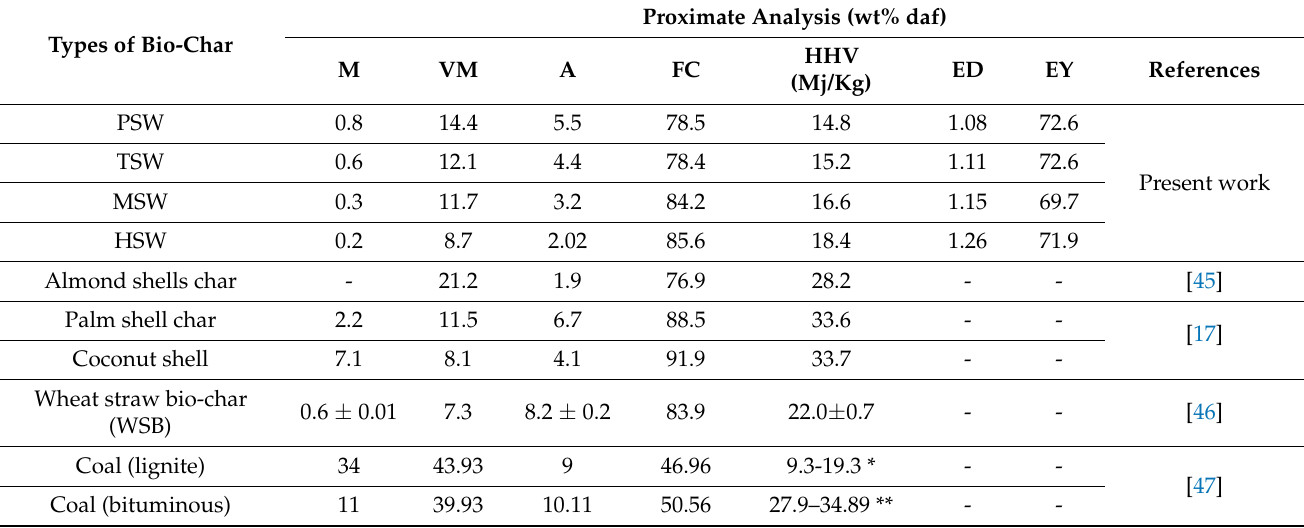
Table 1. Proximate analysis, high heating values, energy density and energy yield of bio-char obtained at particle size of +1.5–2.5 mm, heating rate 20 ◦ C/min at 375 ◦ C and comparison with other